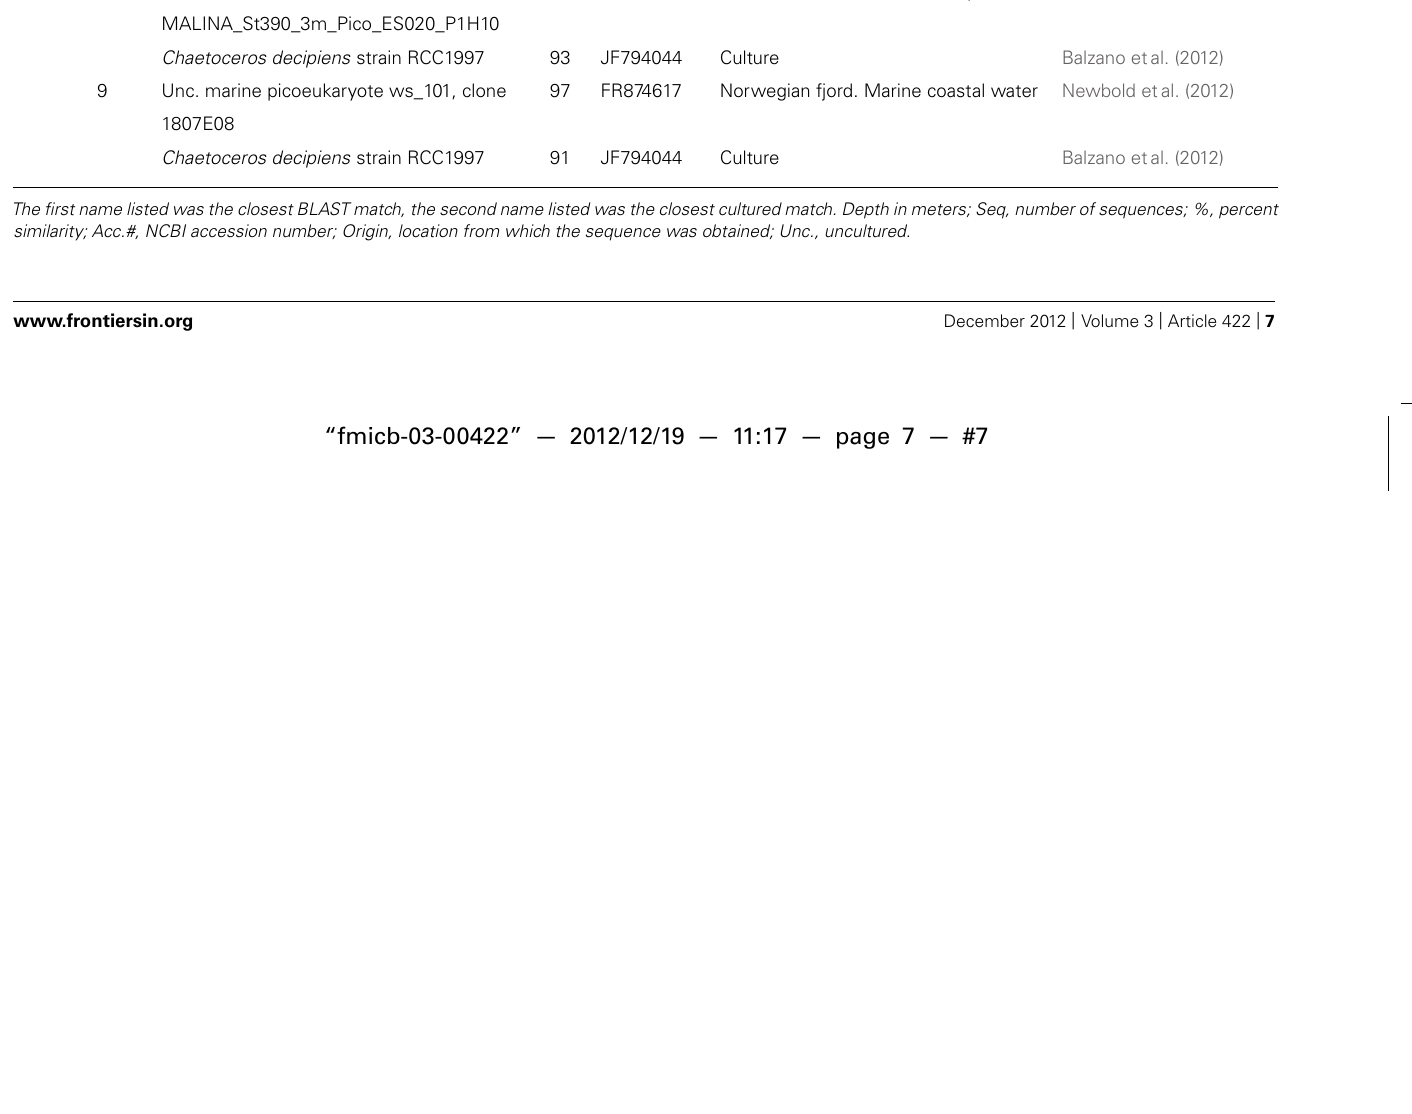
Table 3 | BLAST search results for unclassified diatom sequences in July 2009 samples.